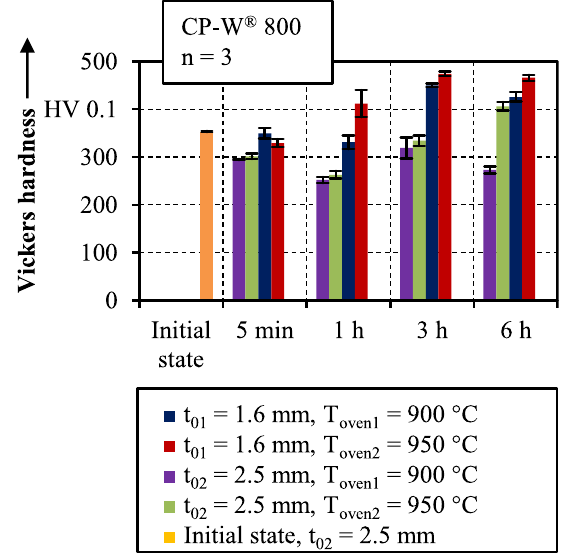
Fig. 5. Vickers hardness of carburized samples in comparison with initial state.